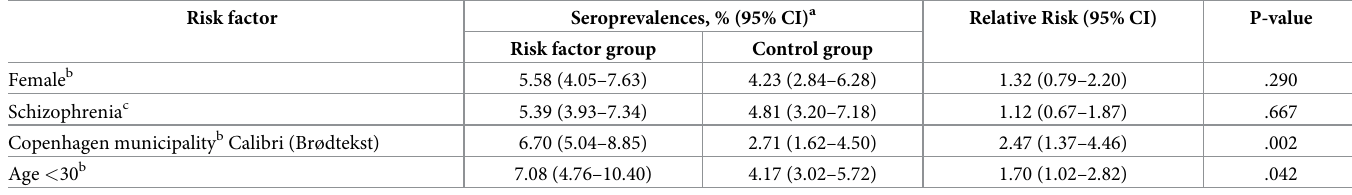
Table 3. Associations between SARS-CoV-2 antibodies and certain risk factors among study